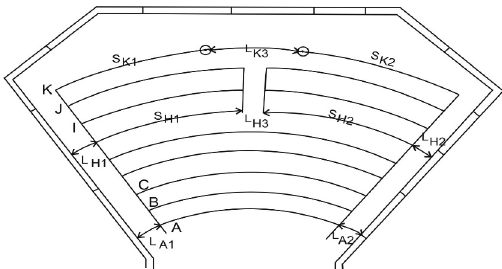
Figure 6. The deviation angles (∆ A , ∆ B , …, ∆ F ) and Figure 7. Presence of intermediate way portion at the curves development lengths (D A , D B , …, D E ) for the curves in a few rows in auditorium together with side way in each row The deviation angle of curve in each row is equal to the difference of bearing angle from the curve centre between the bearing angle goes to the end point of related curve and the bearing angle point goes to the beginning point.